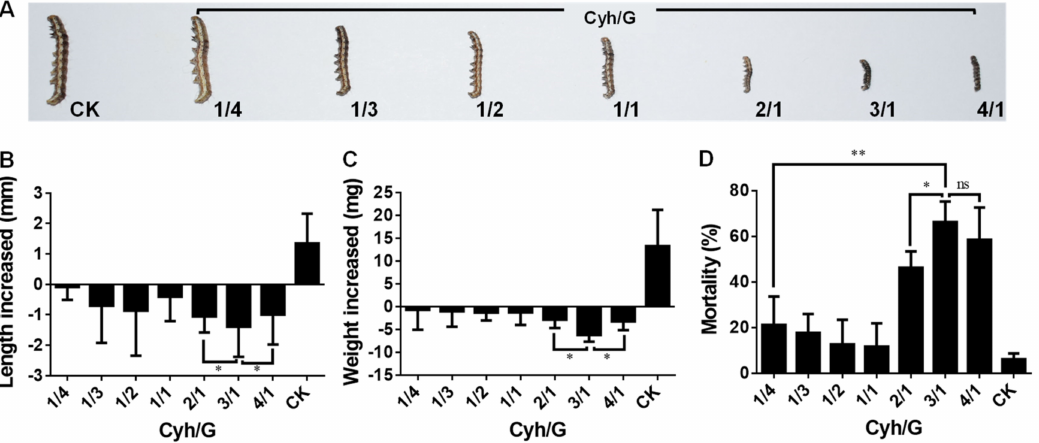
Figure 4. Insecticidal activities of Cyh/G mixtures against cotton bollworm. ( A ) Phenotypic effects. ( B ) Body length change, ( C ) weight change, and ( D ) mortality of the cotton bollworm. CK repre- sents distilled water control. The total concentration of all treatment groups was 100 µ g/mL. Each treatment was performed with four biological replications. Note: statistically significant differences ( α = 0.05 and 0.01 levels) of values are indicated with “*” and “**”, respectively. “ns”: not significant.